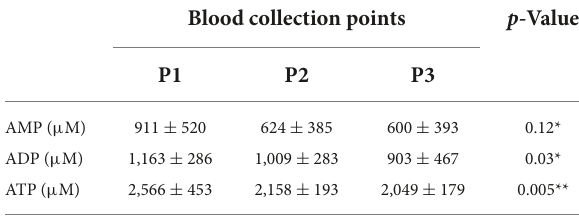
TABLE 2 Nucleotide plasma concentrations at each blood collection